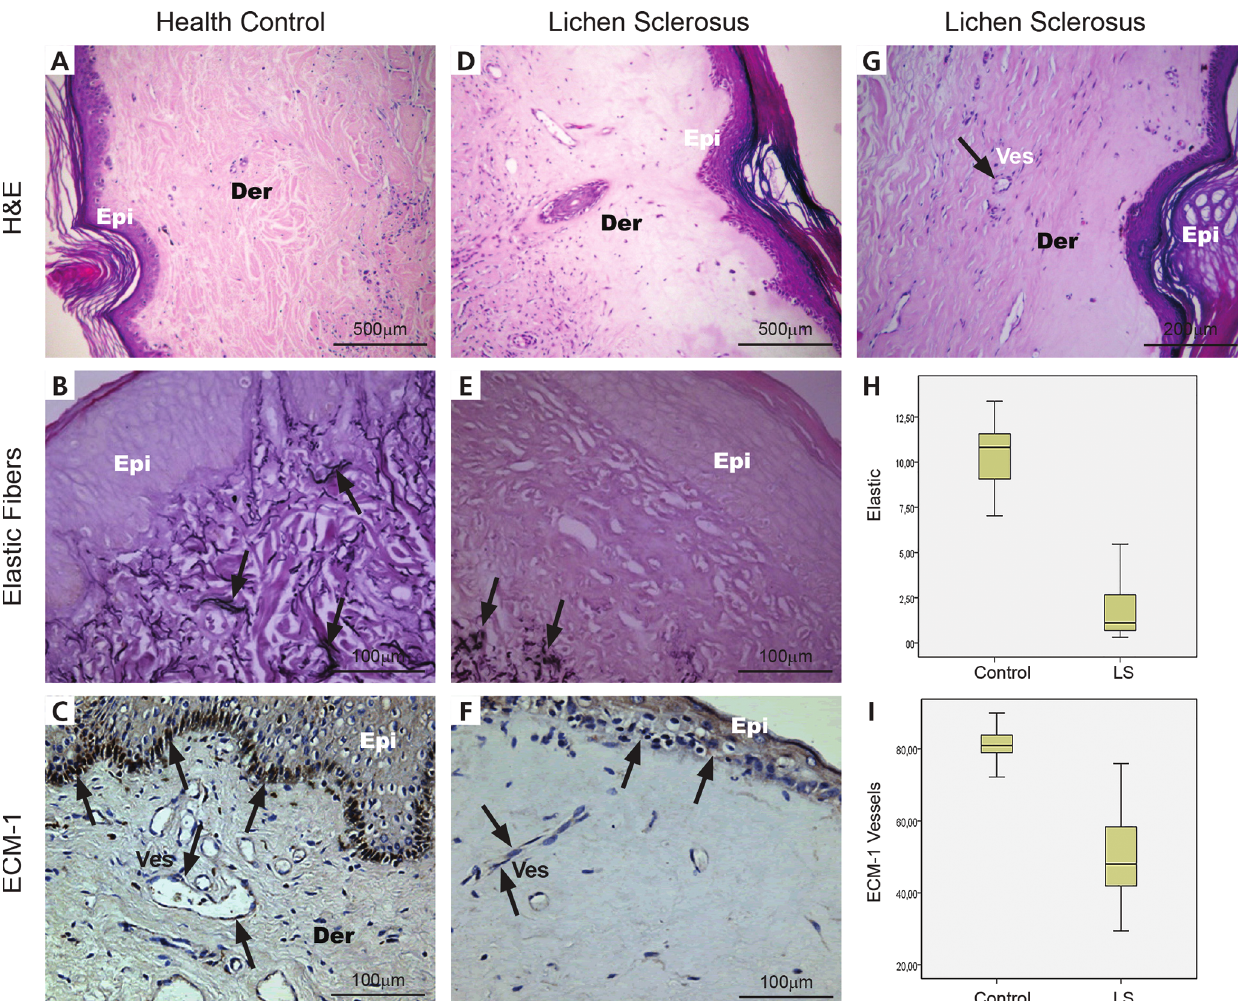
Figure 1 - Histological, histochemical, immunohistochemical and quantitative expression of elastic fibers and ECM 1 in the dermis of healthy controls and lichen sclerosus. (A) A health control biopsy shows a uniform pattern of papillary and reticular dermis; (B) fine black elastic fibers are seen in the papillary and reticular dermis (arrows) and (C) the regular brownish color of ECM 1 expression is in the superficial epidermis and small vessels of the reticular dermis (arrows). (D and G) Lichen sclerosus exhibits upper dermal homogenization with subepidermal separation; (E) disappearance of elastic fibers were seen, whereas (E) elastic fibers in the reticular to deep dermis mostly appeared normal or showed a mild increase just beneath the hyalinized zone (arrows); (F) mild or absent brownish color of ECM 1 expression in superficial epidermis and small vessels (arrows). (H) A significant decrease in elastic fibers is present in the hyalinization zone of LS compared to control skin. (I) In addition, the hyalinization zone from LS skin presents a significant decrease of ECM 1 protein expression compared to healthy controls ( p o 0.001). (H&E: A, X40; D, X40; G, X100 magnification); (Resorcin: B and E X200 magnification); (ECM immunostaining: C, X200; F, X200 magnification) (Der=dermis, Epi=epidermis,